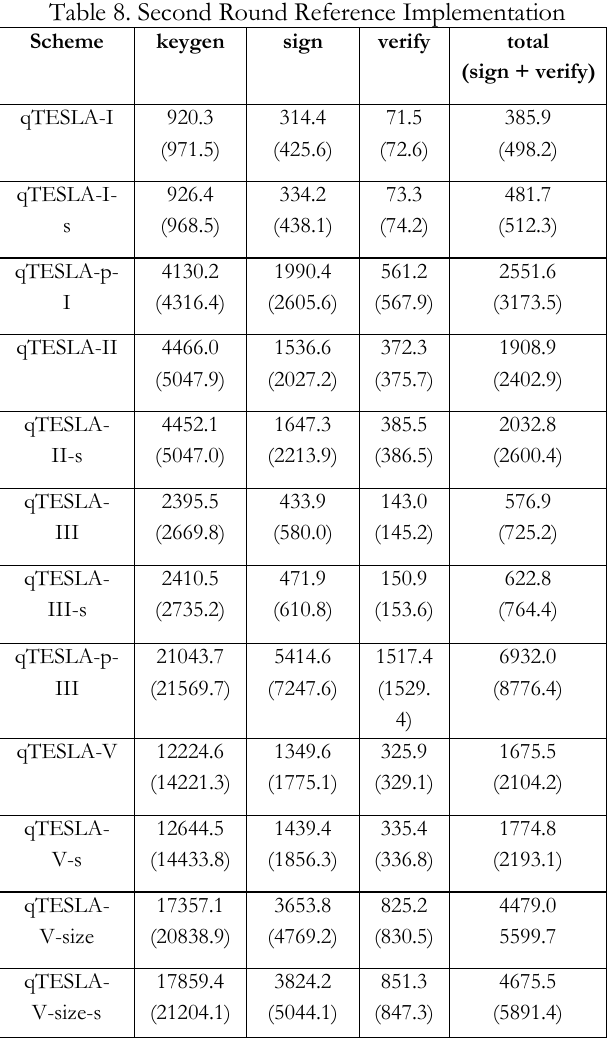
Table 8. Second Round Reference Implementation